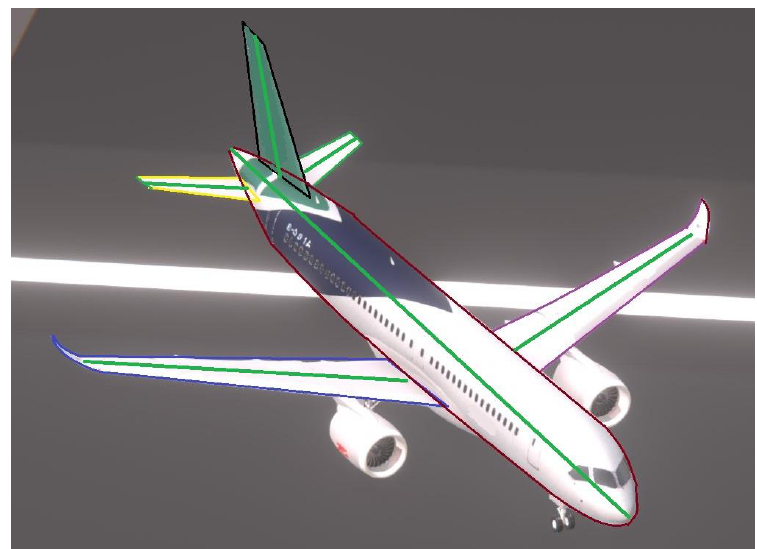
Figure 7. The six parts of an aircraft: fuselage, the left and right wings, the left and right horizontal tails, and the vertical